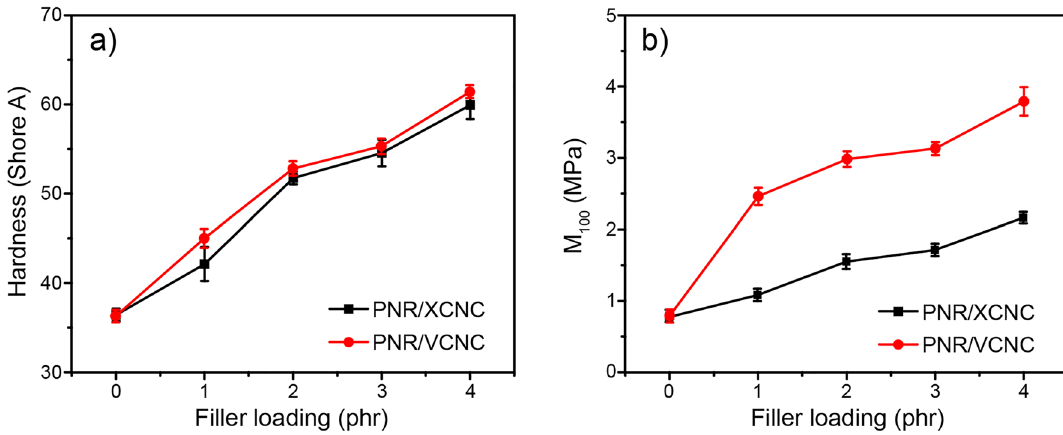
Figure 11. Resistance to deformation of the biocomposites; ( a ) hardness and ( b ) modulus at 100% strain (M 100 ).